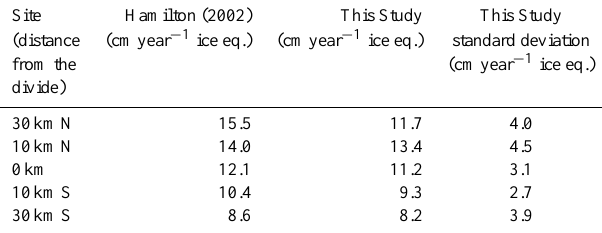
Table 3. Comparison of Siple Dome net accumulation rate stud- ies from 1955 to 1995, expressed as water equivalents. The stan- dard deviation of net accumulation is also shown for this study. The Hamilton (2002) study standard deviation is not available because the data is not a time series, but rather a long-term average based on the 1955 bomb testing reference